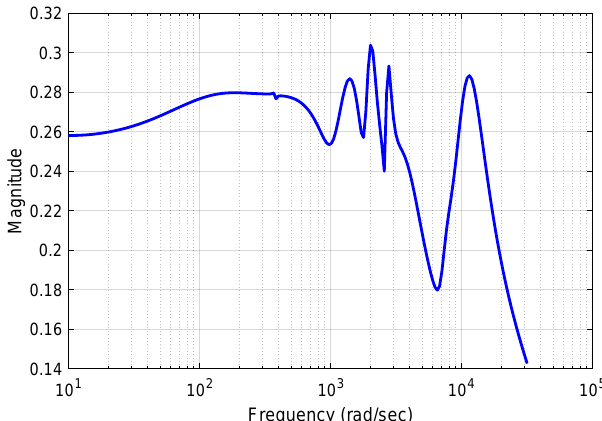
Figure 9. Robust control condition for the sequential design in Equation (13) (Step 1 of the proposed 5-step design procedure).